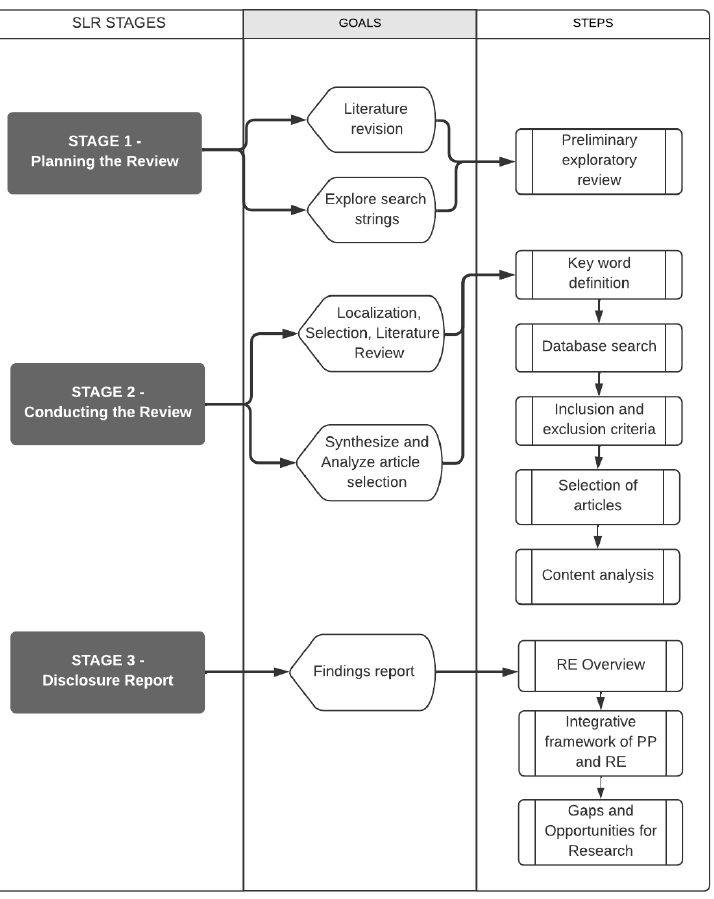
Figure 1. Descriptive summary of the systematic literature review. Source: Adapted from Tranfield et al. [22].